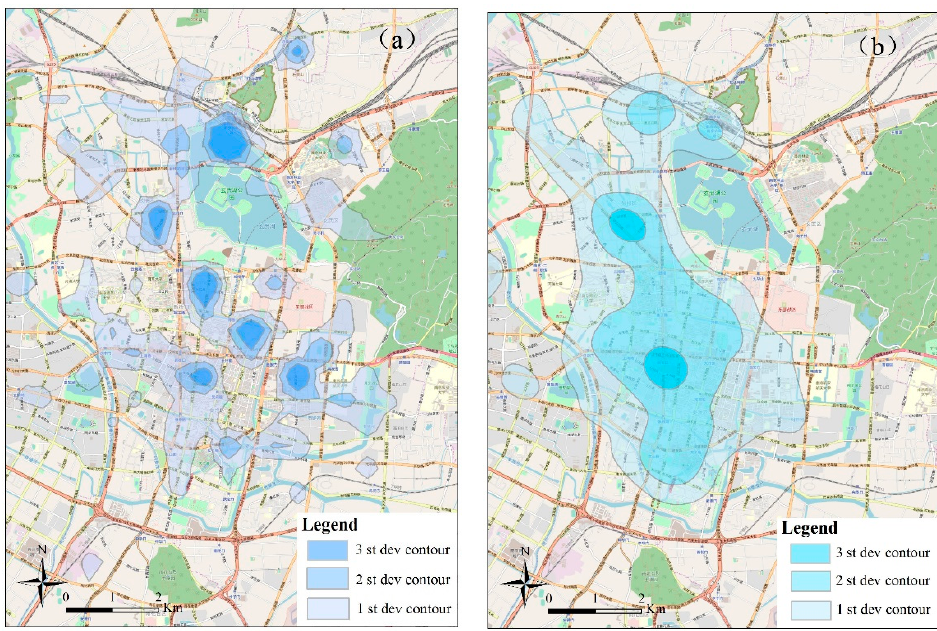
ISPRS Int. J. Geo-Inf. 2019 , 8 , 344 Figure 10. Three standard deviations isolines of urban hotspot centredness computed by two methods. ( a ) NSF (network-based spatiotemporal field) method; ( b ) KDE (kernel density estimation) method.